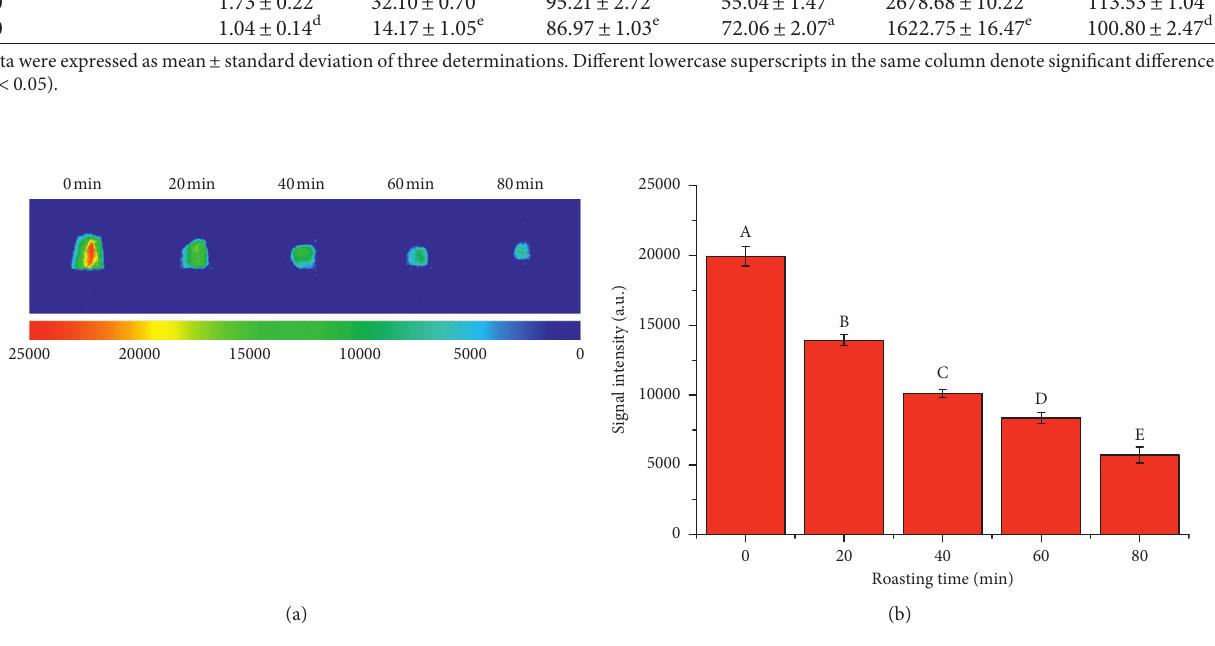
Figure 4: Proton density weighted magnetic resonance images of giant salamander jerky with different roasting times (a) and the corresponding histogram of quantitative signal intensity (b).